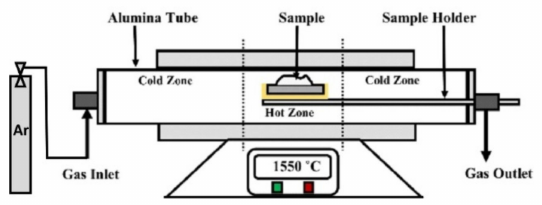
Figure 3. High-temperature experimental approach.